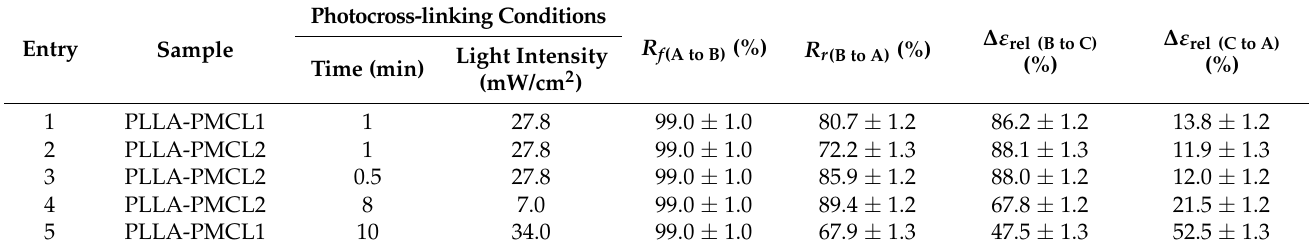
Table 4. Triple-shape-memory properties of poly(L-lactide) (PLLA)-poly( ε -caprolactone) (PMCL)